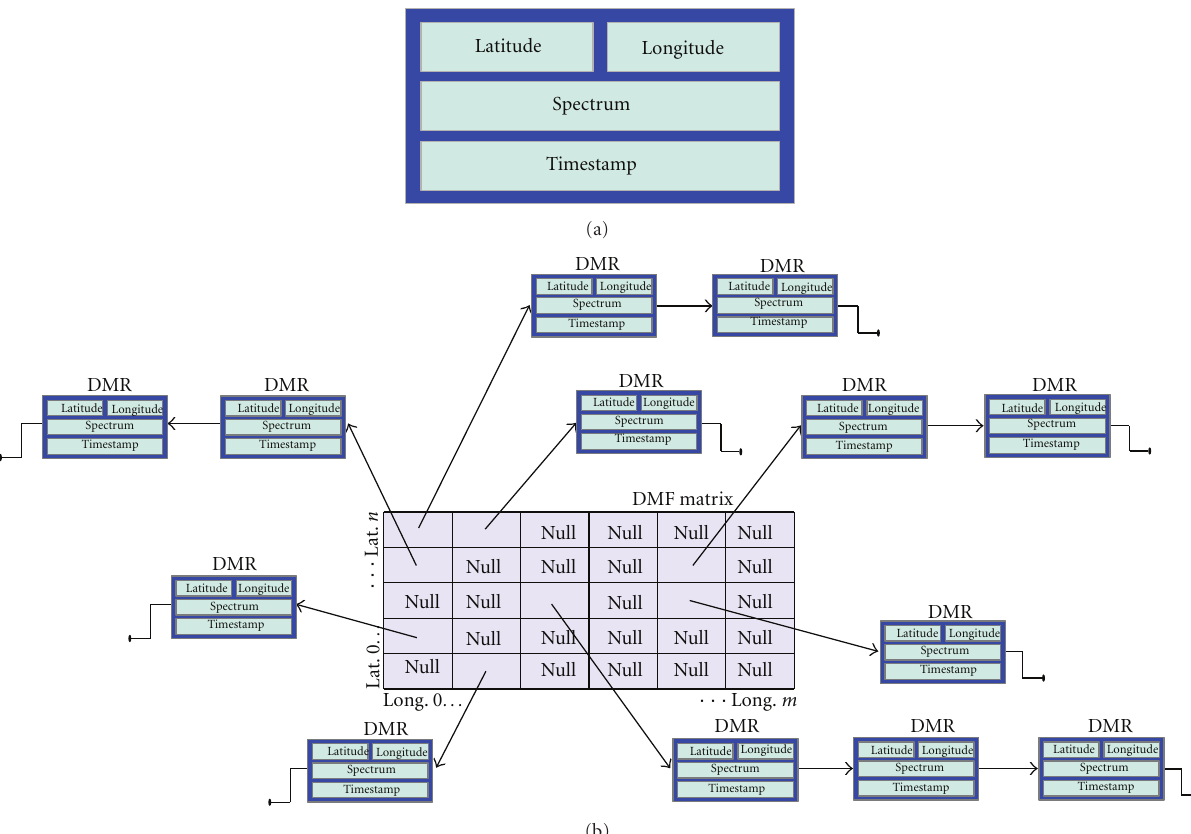
Figure 2: (a) Representation of the DMR record adapted for change detection; (b) representation of the DMF matrix adapted for change